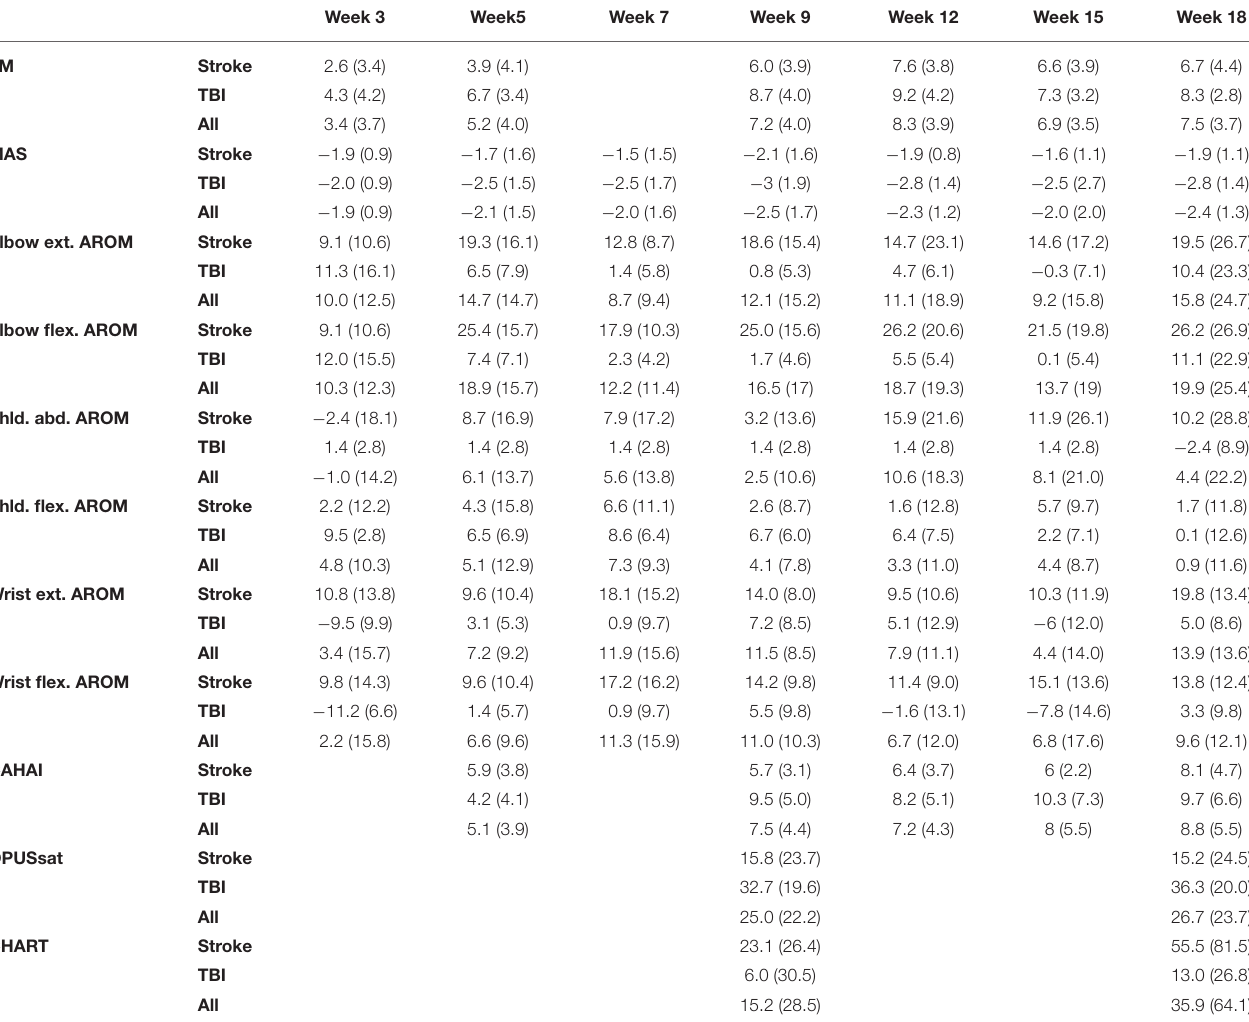
TABLE 3 | Outcome measure changes at different time points (mean